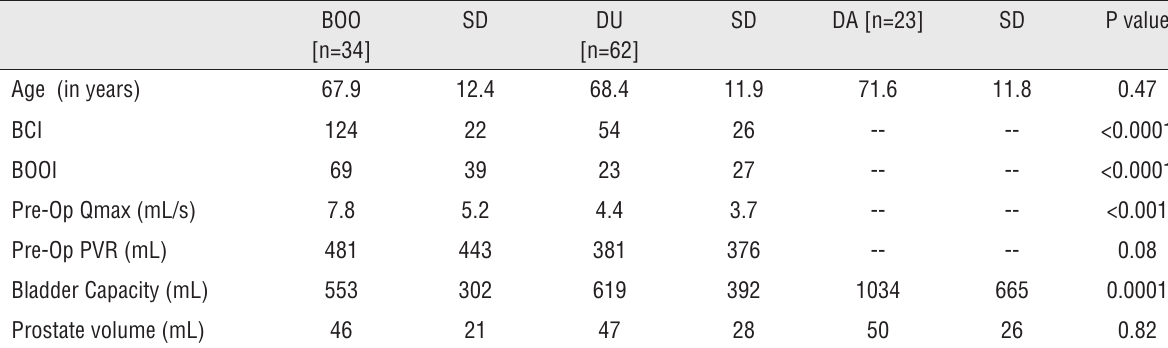
Table 2 - Preoperative data.